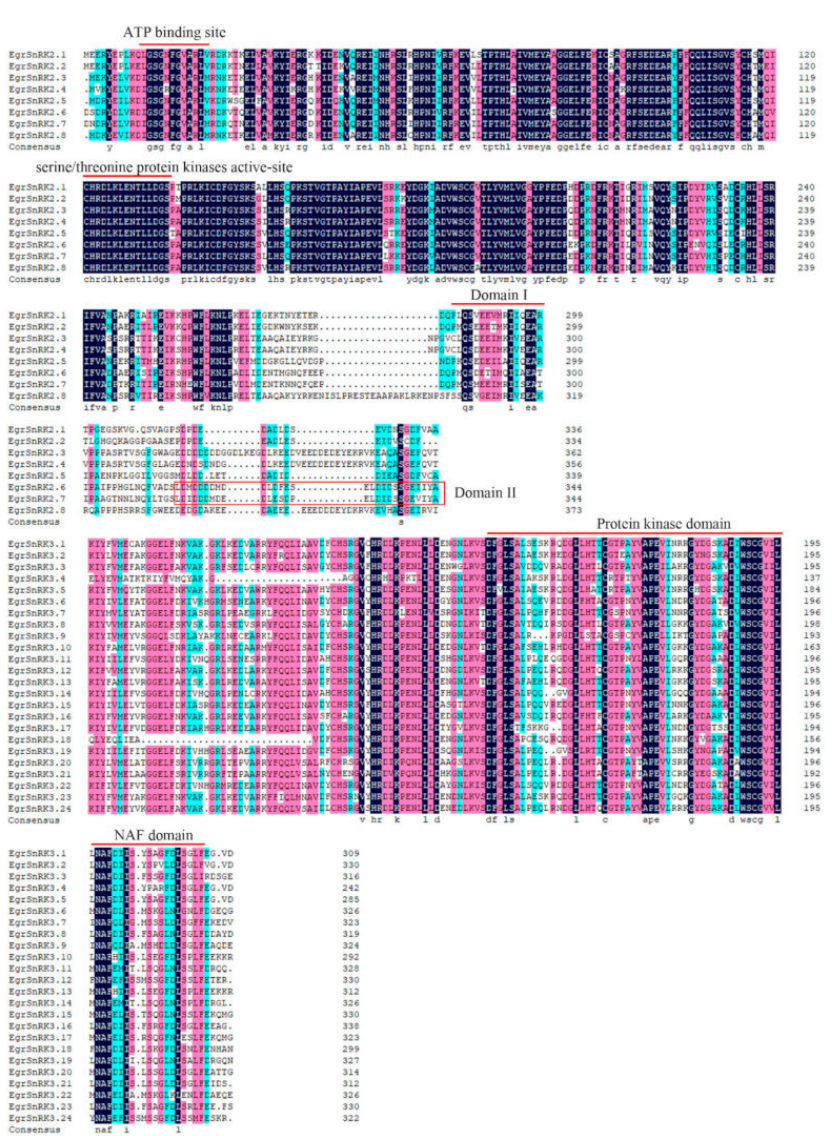
Figure 2. Multiple sequence alignment of SnRK genes in E. grandis . Sequences were aligned using DNAMAN 8